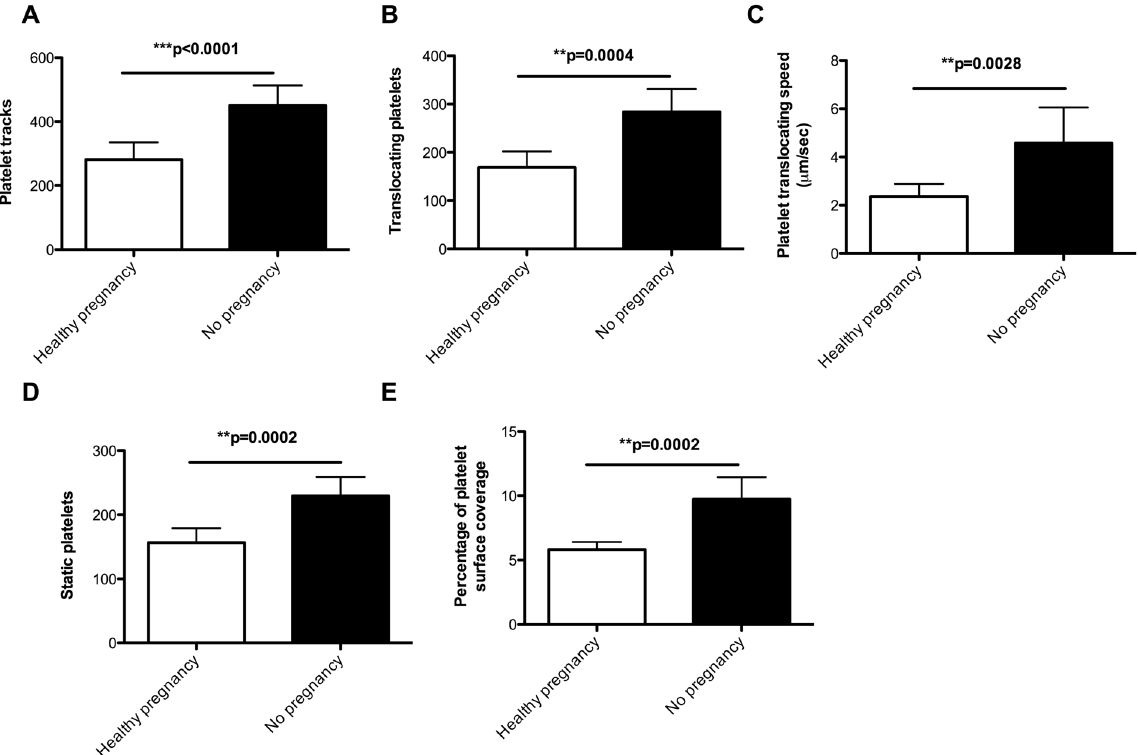
Figure 1. Platelet function on VWF is reduced during pregnancy. Blood from 21 pregnant females in the third trimester of pregnancy and 21 healthy non-pregnant female controls were perfused over VWF at arterial shear rates. Platelet function on VWF was measured using the dynamic platelet function assay. Pregnant females showed a significant reduction in platelet function on VWF ( * p < 0.05, ** p < 0.01 and *** p < 0.0001). Data are presented as mean ± 95% confidence interval.